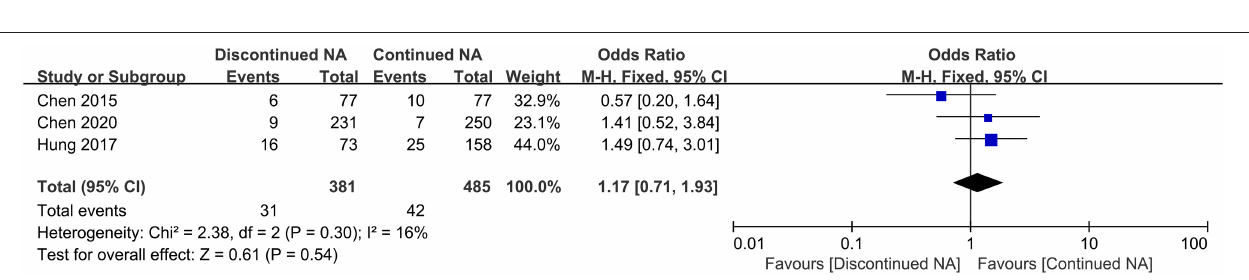
FIGURE 4 | Forest plots on incidence of hepatocellular carcinoma comparing between continued Nucs therapy and discontinued Nucs